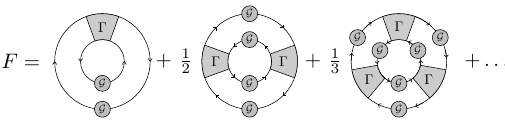
Figure 11 . Hierarchy of wheel diagrams contributing to the two-point double-trace correlation function (5.2), which in turn corresponds to the contraction of indices in (cid:12)gure 4 leading to L . The combinatorial factor 1 =m corresponds to rotational symmetry and prevents overcounting the dia-